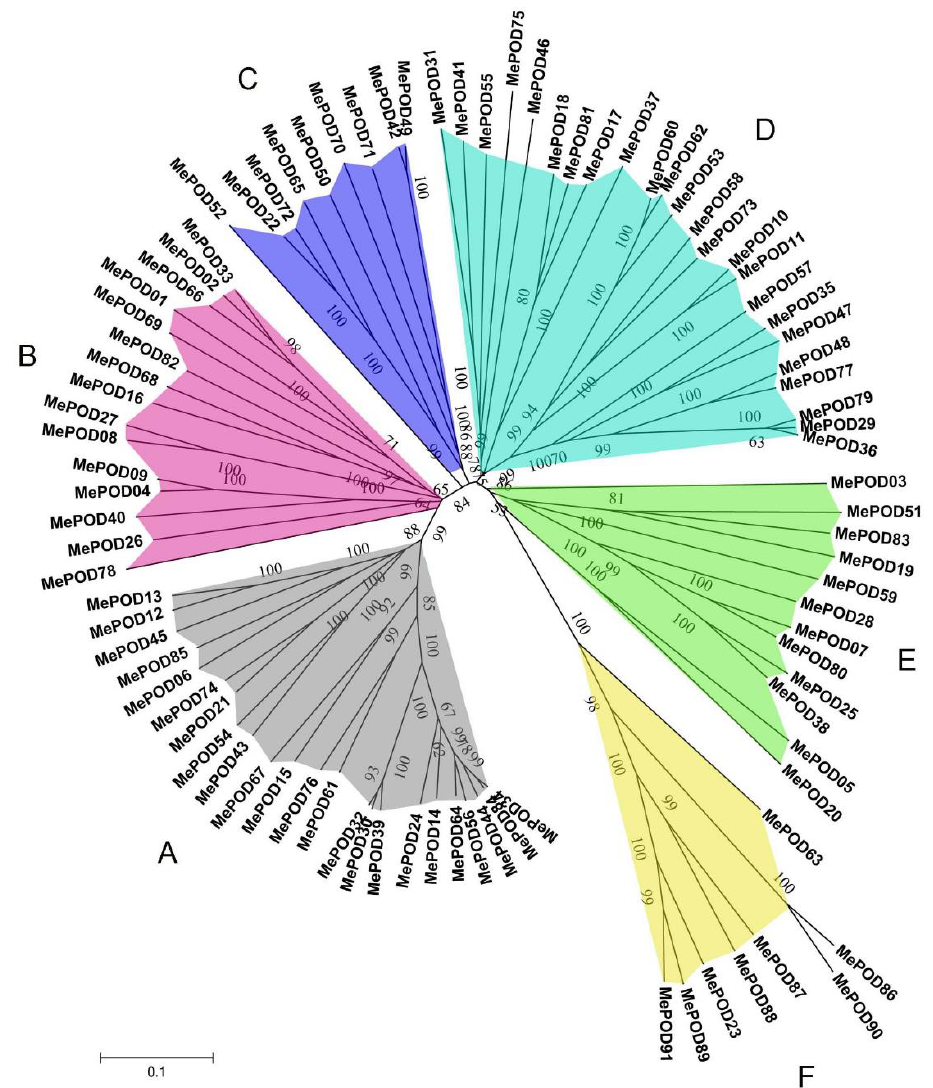
Figure 1. Phylogenetic analyses of PODs from cassava. A total of 91 PODs from cassava were used to create the neighbor-joining (NJ) tree with 1000 bootstraps.